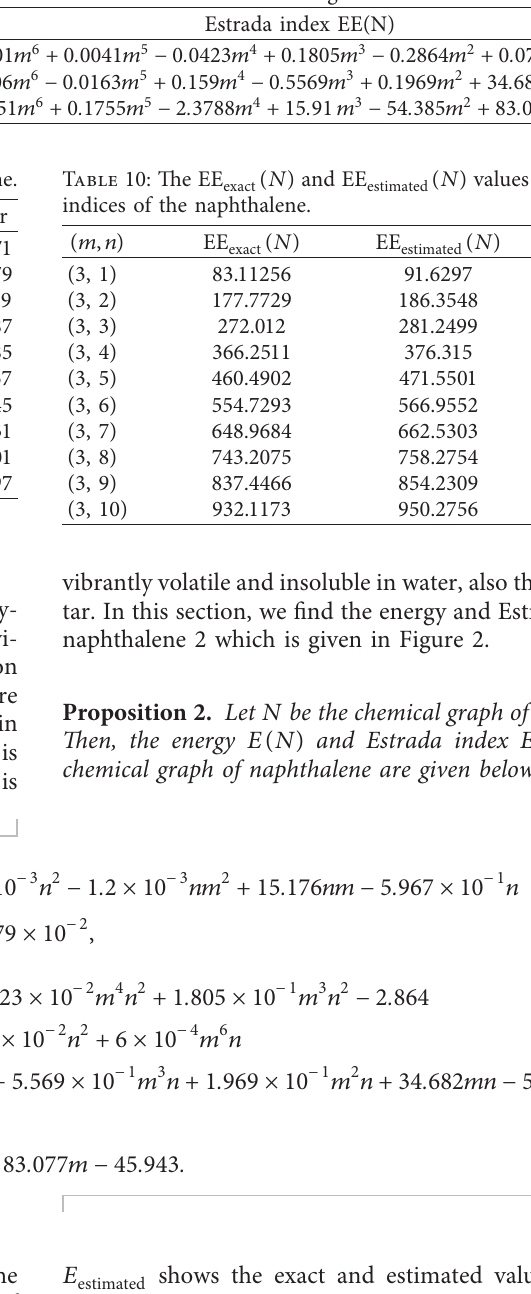
Table 8: The polynomial of order 2 derived from the coefficient of the curves given in Table 6. n Estrada index EE(N) n